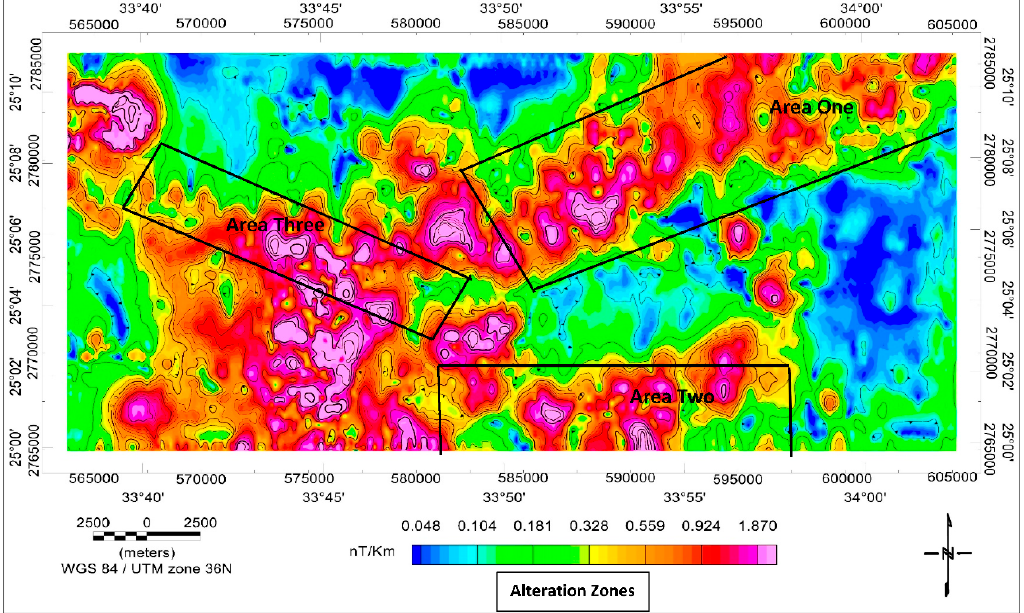
Figure 7. The research area's AS map